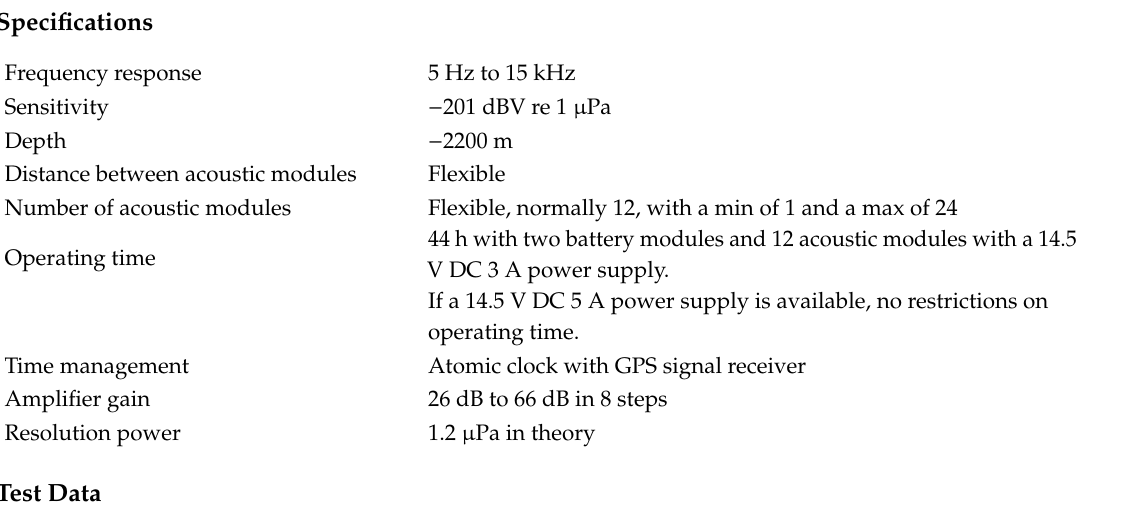
Figure 9. External view of the battery module.